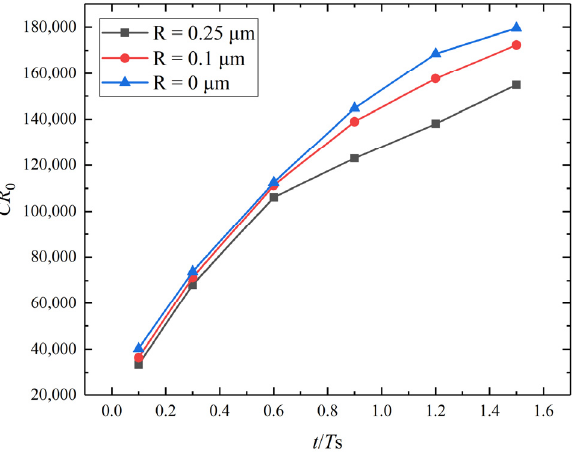
Figure 12. Dimensionless corrosion rate versus dimensionless time for different cavity sizes.